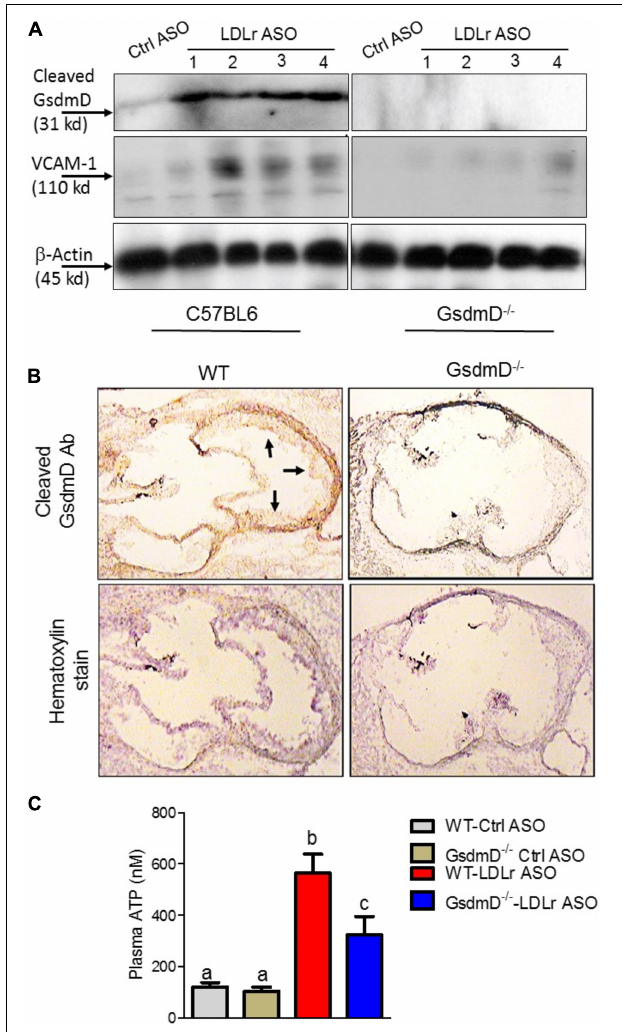
FIGURE 7 | Gasdermin D (GsdmD) is cleaved in atherosclerotic plaques. (A) The 12-weeks old mice were injected with either control or LDLr ASO for 9 weeks and were fed western type diet throughout the course of study. Mice were euthanized after 9-week ASO treatment and protein extracts from aortas of control ASO or LDLr ASO treated mice ( N = 4) were subjected to western blot analysis using antibody specific for cleaved GsdmD and VCAM-1. GAPDH was probed as a loading control. (B) The fresh Frozen hearts were sectioned, followed by antigen retrieval and endogenous peroxidase activity blocking, and probing with antibody specific for cleaved N-terminal fragment of Gasdermin D. The arrows represent positive signal for cleaved GsdmD. (C) ATP levels in plasma of control ASO or LDLr ASO treated mice fed with atherogenic diet were determined by ATP quantification kit, following manufacturer’s instructions. (mean ± SD, N = 8; different letters show p < 0.001, by ANOVA Bonferroni